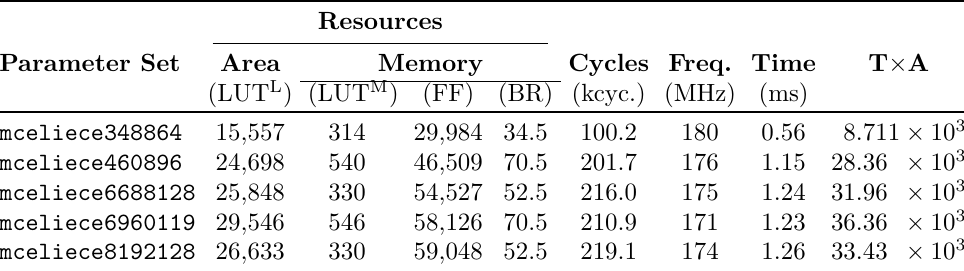
Table 10: Comparison of the time and area for our Decap hardware module targeting Xilinx Artix 7 ( xc7a200t )